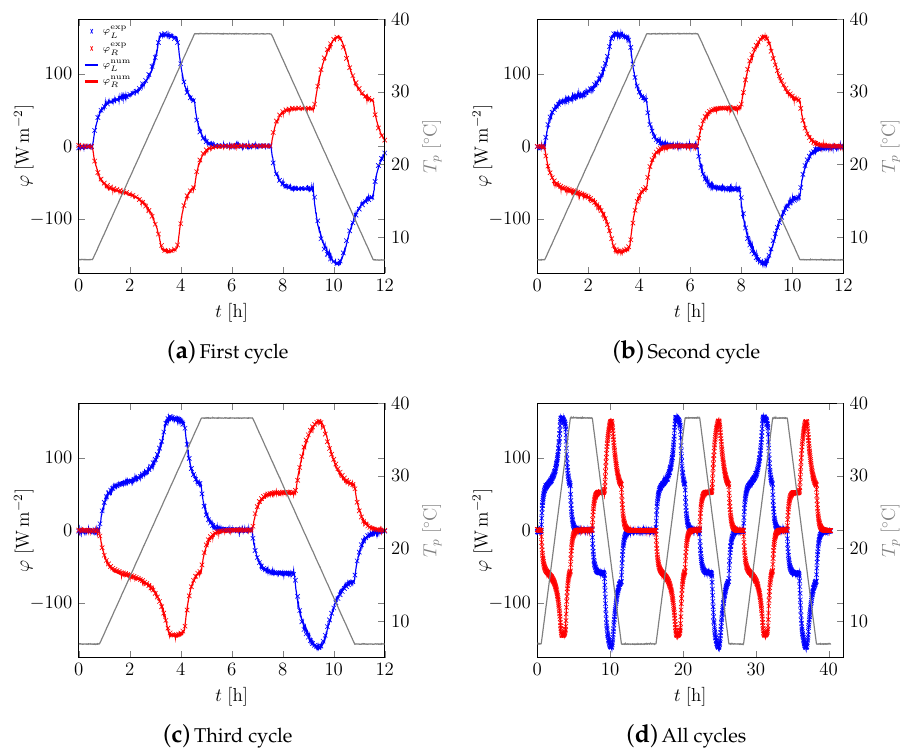
Figure A10. 22.1% w -PCM mortar: comparisons of the experimental fluxes with the numerical ones after identification for the 4h heating/cooling ramp experiment.